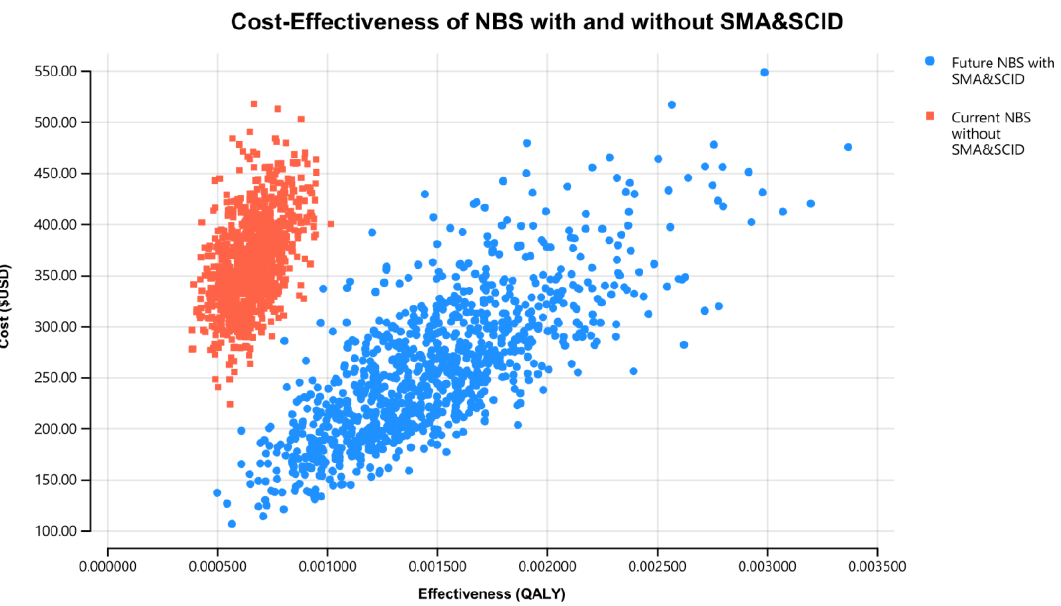
Figure 4. Total cost and total QALYs for combined NBS for SCID and SMA treated with early HSCT and gene therapy and no screening for SCID and SMA, government perspective, 60 years, USD 2018.